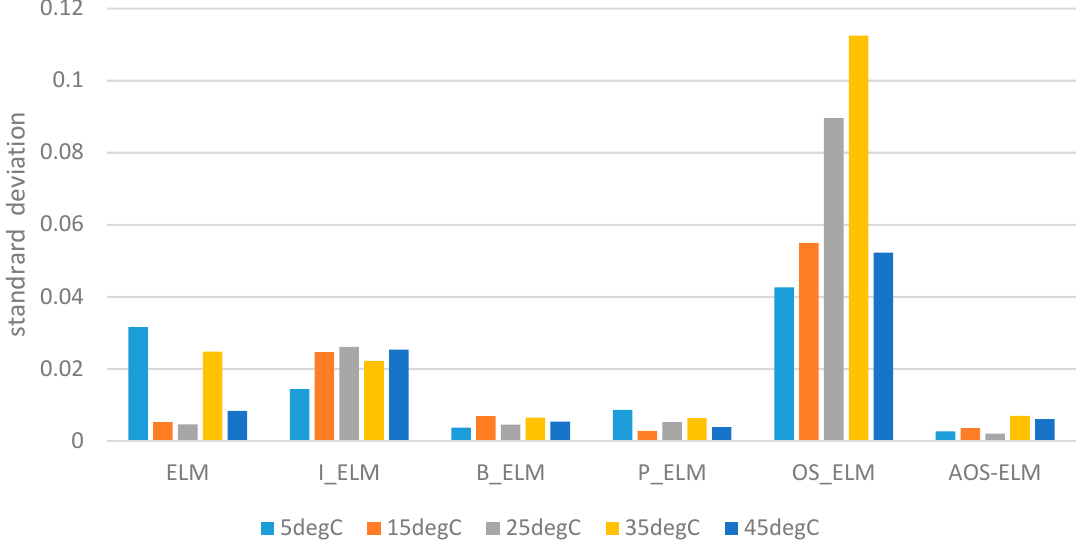
Figure 17. SOC standard deviation of adaptive online sequential ELM (five neurons).